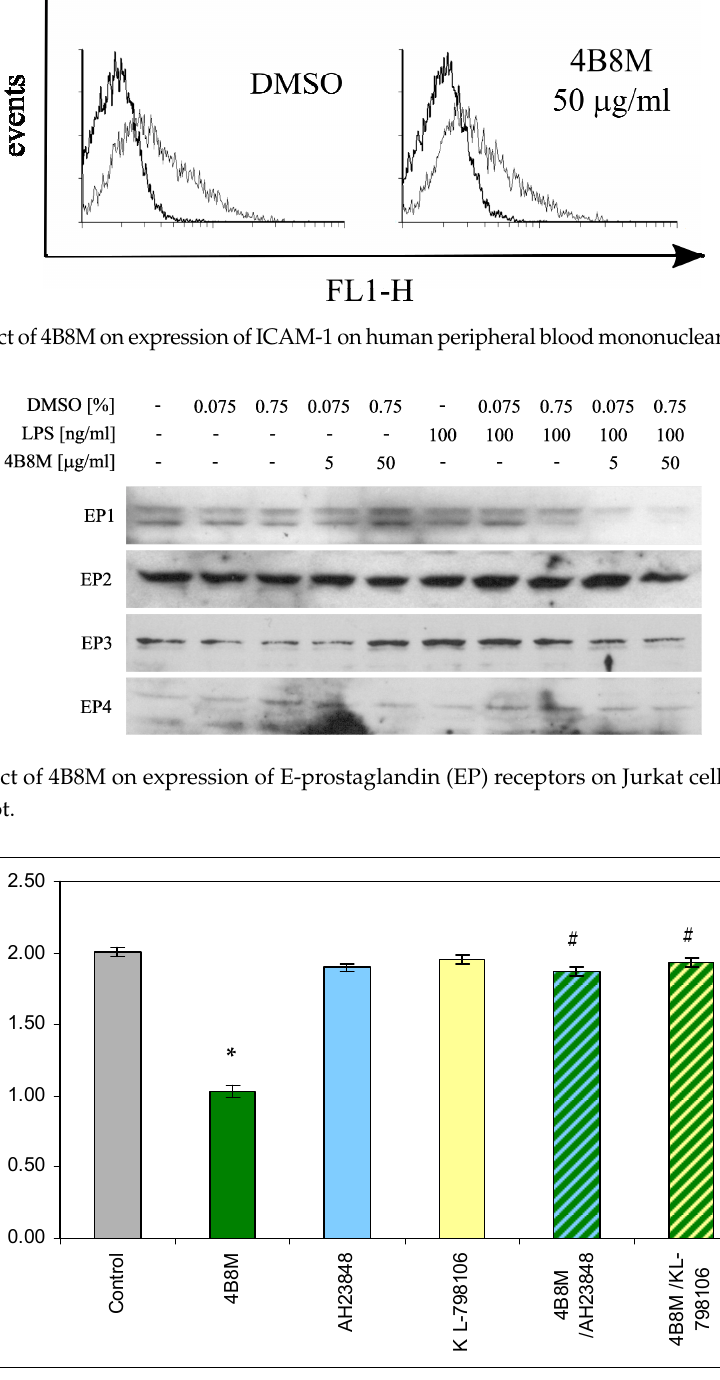
Figure 15. Antagonists of EP4 and EP3 receptors for PGE2 abolish the suppressive action of the peptide in carrageenan-induced foot pad edema in mice. The mice were injected with 4B8M (250 µg/mouse) i.p. 1 h before s.c. carrageenan administration. PGE receptor antagonists AH23848 (EP4